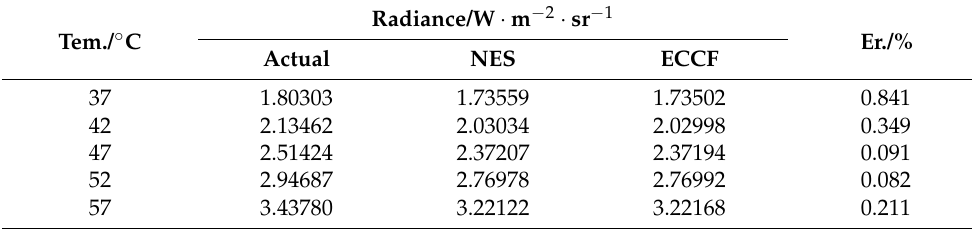
Table 4. The inversion data of two calibration methods, and the error between them. Tem./ ◦ Table 5. The error of calculation results of two methods and the actual value. Tem./°C